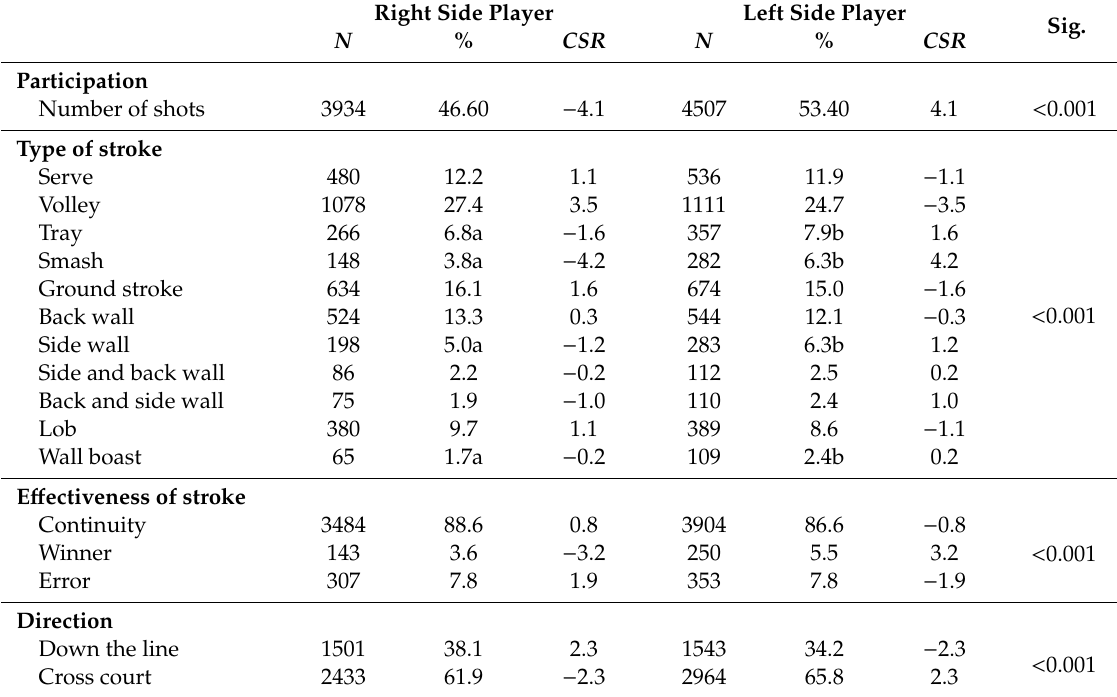
Table 2. Di ff erences in the number and type of strokes, their e ff ectiveness, and direction depending on the playing side of the court.